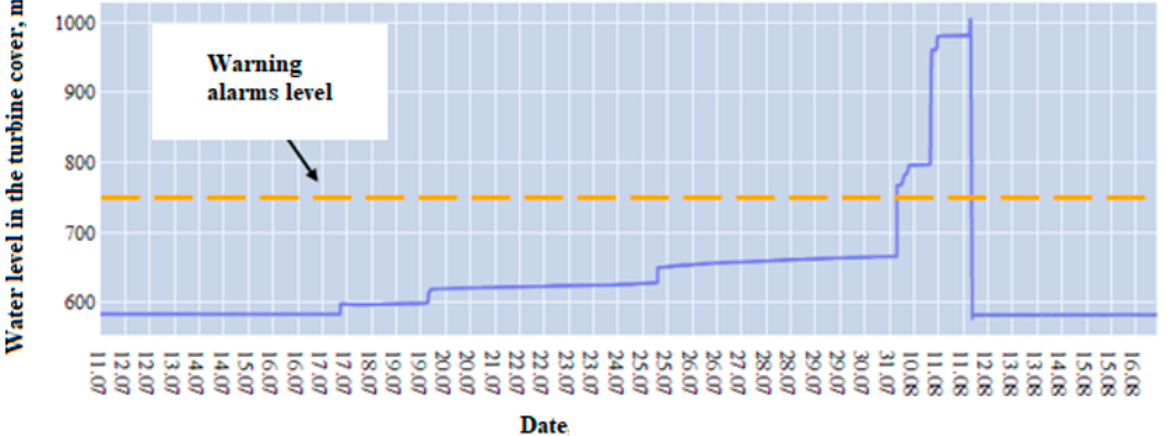
Figure 5. Behavior of the parameter “water level in the turbine cover”.